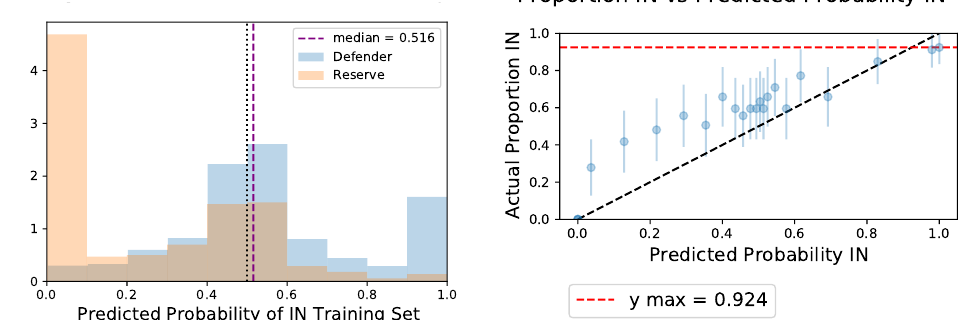
Figure 3. Left: Histograms of predicted probabilities of membership IN the Defender set, for the Defender set and the Reserve set, each of size 1000. Right: Scatter plot comparing the actual proportions of being IN the Defender set with the predicted probabilities of membership IN the Defender set, for groups of 40 samples with similar predictions (with error bars for proportion). Many Defender samples are correctly predicted members with high